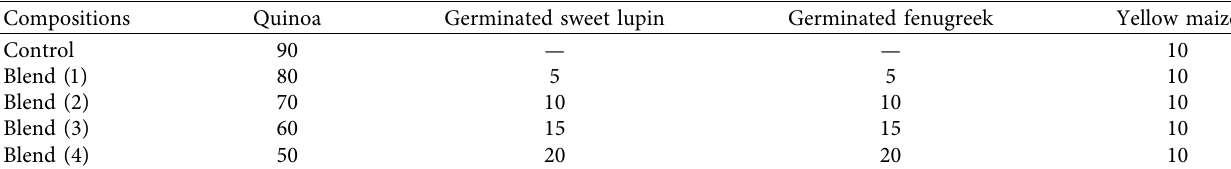
Figure 1: Schematic development of multigrain pan bread and Table 1: Recipe of different blends pan bread.